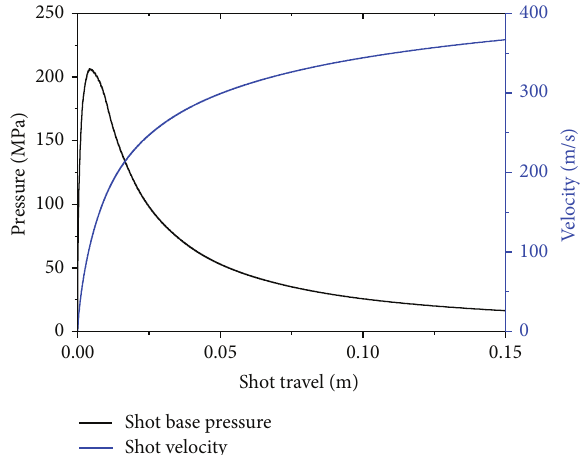
Figure 8: Mach number time history for 𝑚 𝑝 = 0.245 g, without barrel friction.